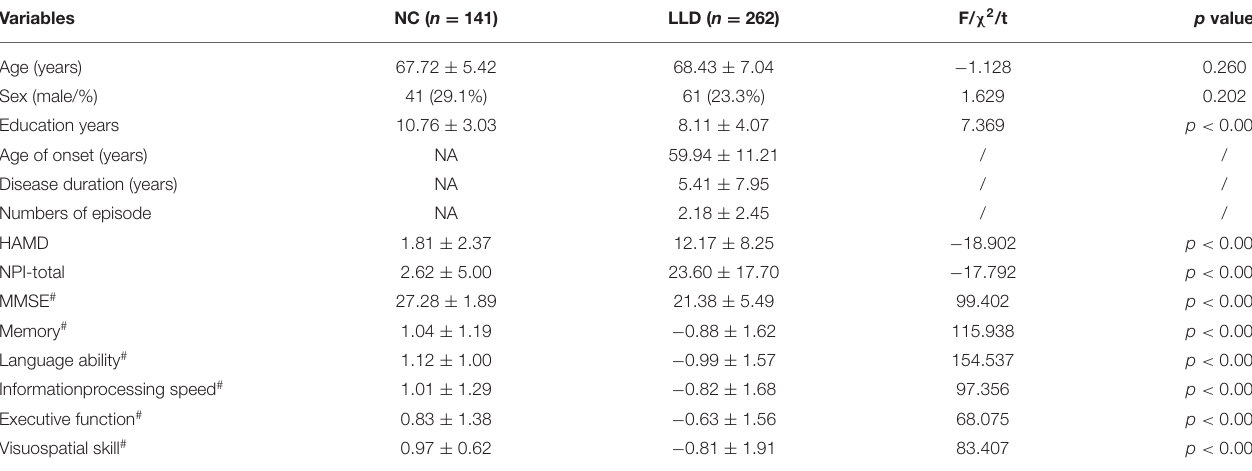
TABLE 1 | Demographic, clinical symptoms, and neuropsychological information.